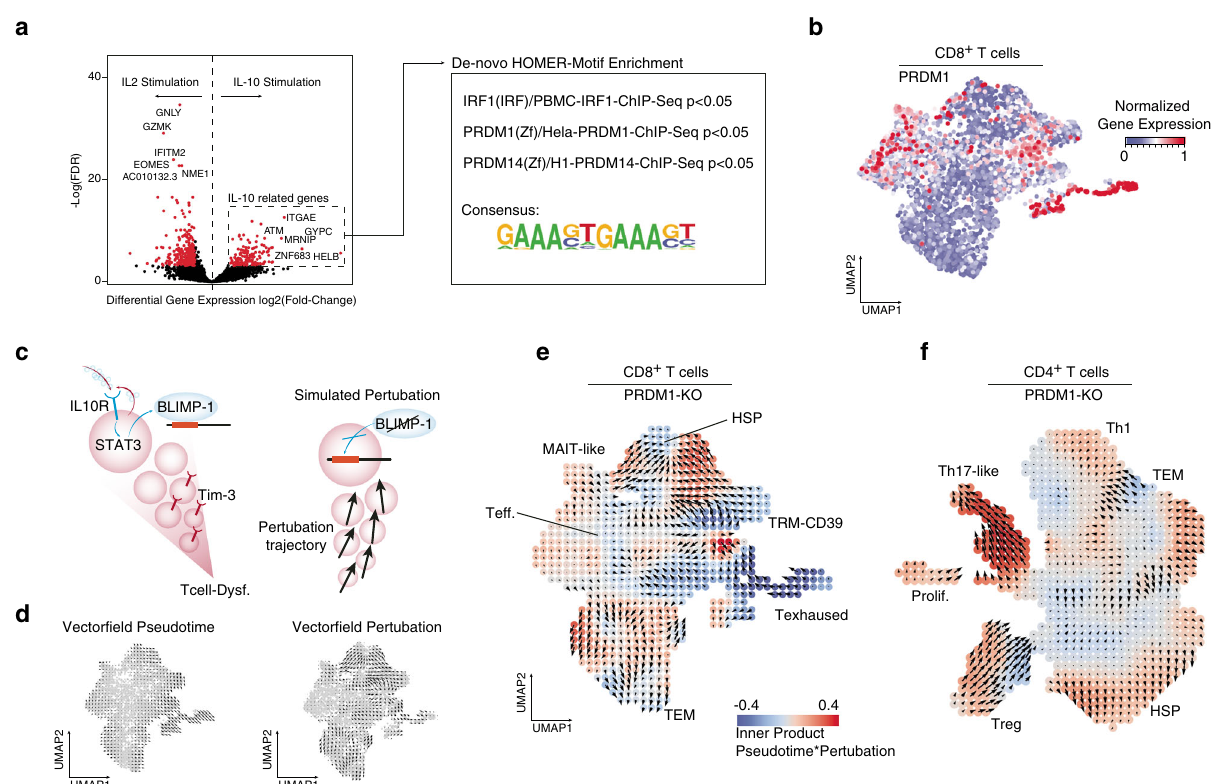
Fig. 3 Perturbation simulation of IL-10 response in T cells. a Volcano plot the differential gene expression of IL-2 and IL-10 stimulated T cells. Signi fi cantly expressed genes (IL-10 related genes) are analyzed by HOMER (Software for motif discovery and next-generation sequencing analysis) for de novo motif enrichments. The top three candidates are shown in the right box. b UMAP representation of CD8 + T cells expressing the PRDM1 gene. c Illustration of the hypothesis of PRDM1 perturbation. d Vector fi eld projection of the development trajectories (RNA-velocity) (left) and the perturbation trajectories (right) in CD8 + T cells. e CD8 + T cells: Vector fi eld projection of the inferred perturbation (PRDM1), colors indicate the inner product from both development and perturbation trajectories. f Similar presentation as ( e ) from CD4 + T